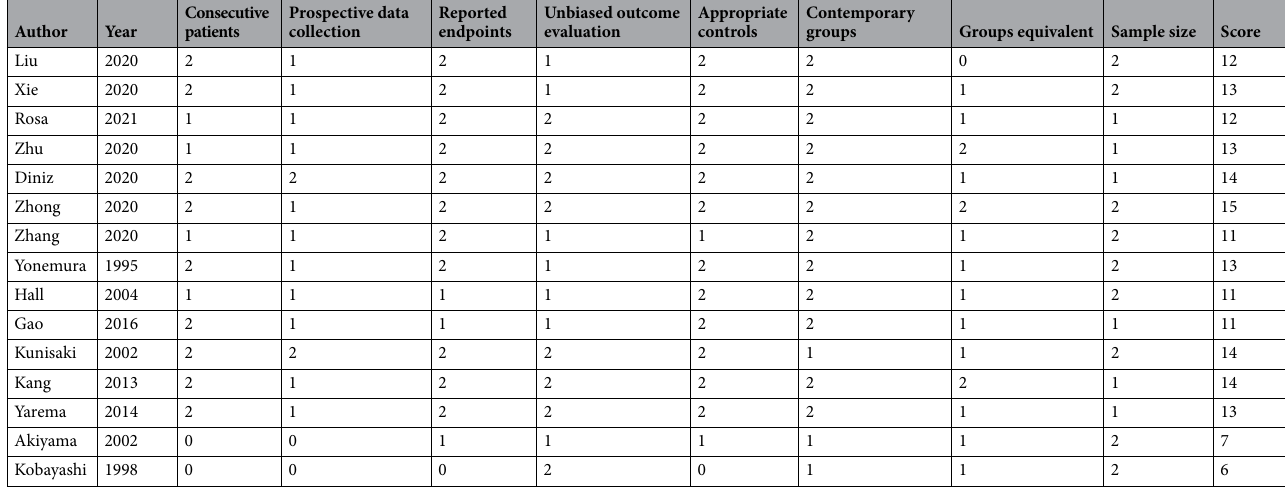
Table 1. Modified MINORS score of all eligible NRCT. MINORS methodological index for non-randomised studies, NRCT Non-Randomized Controlled Trial. Only studies with scores > 12 can be included in the meta-